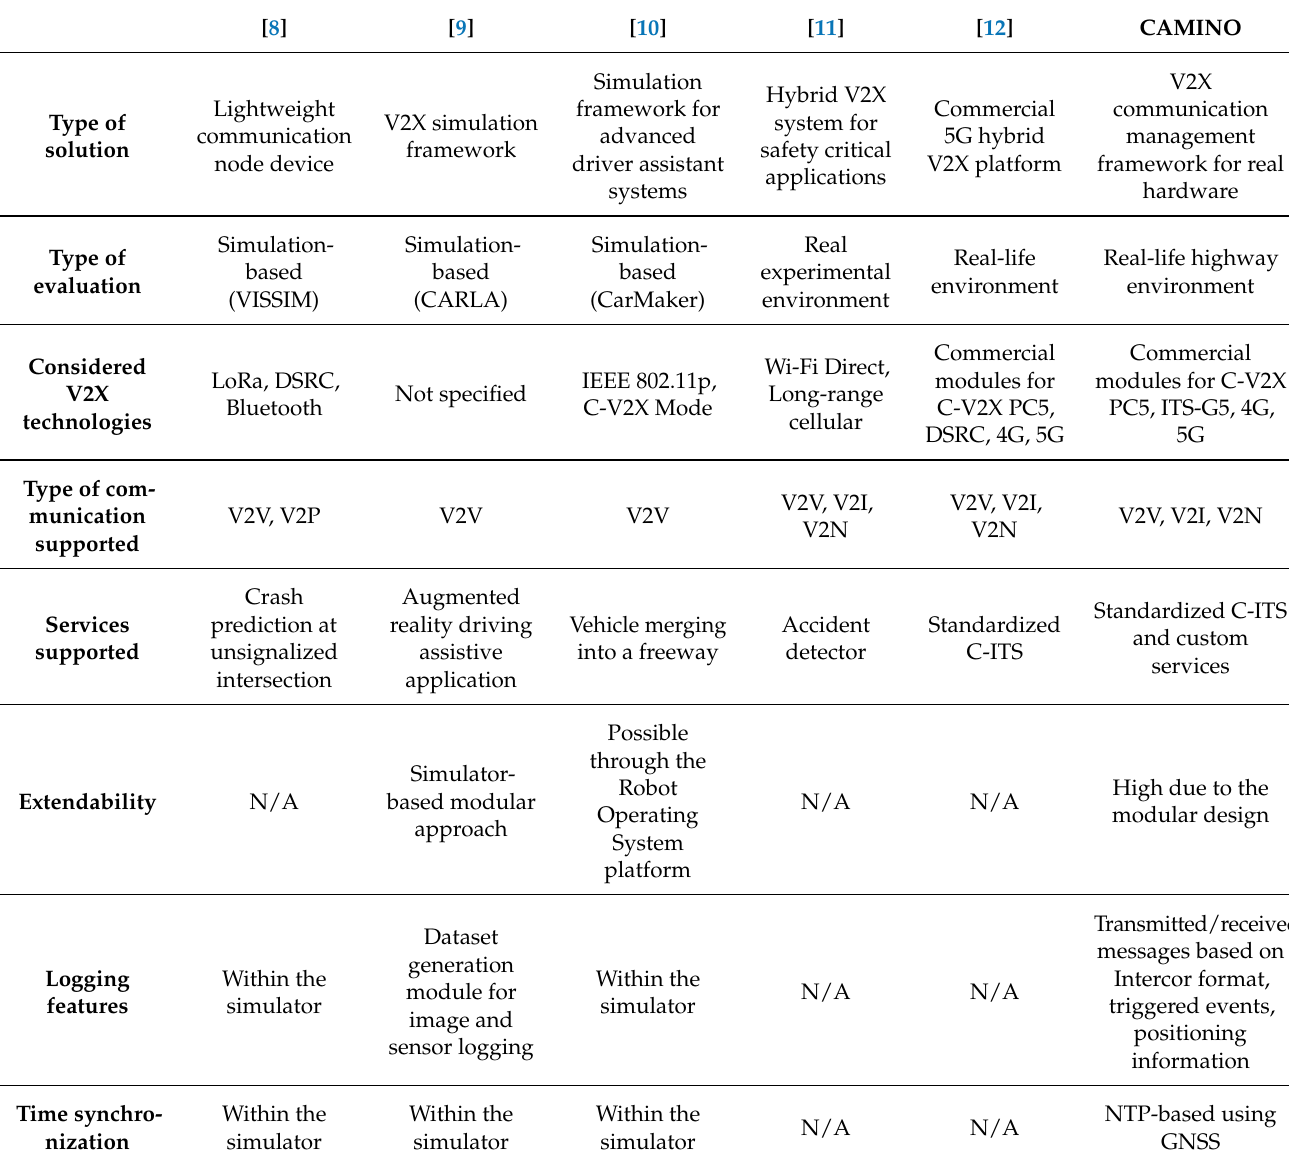
Table 1. Comparison of the vehicular communication management framework (CAMINO) with other state-of-the-art solutions on several key